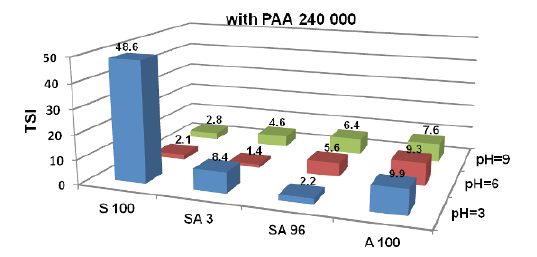
Figure 2. TSI values for the suspensions of various adsorbents with PAA 2 000 at different pH values.